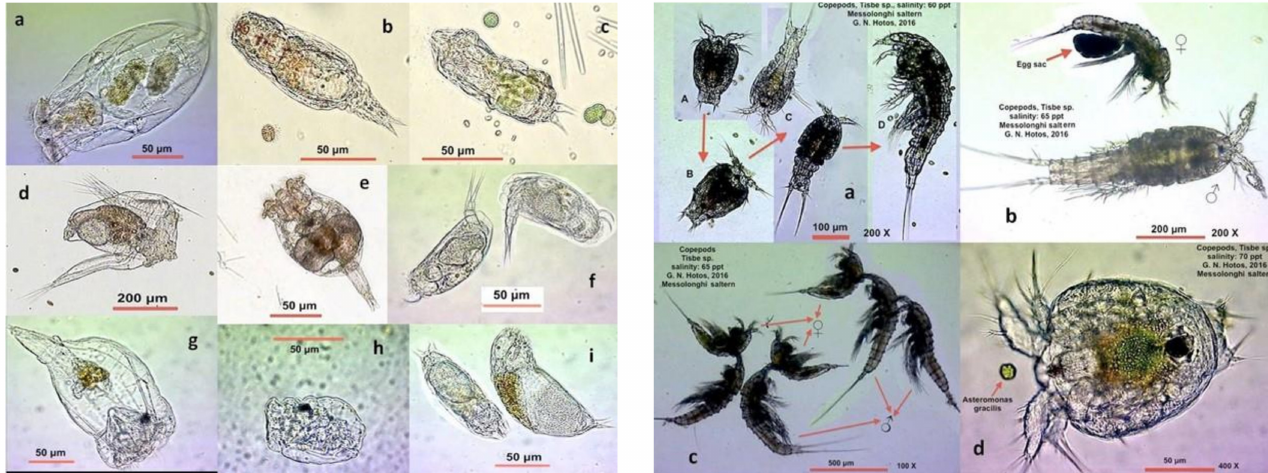
Figure 5. Metazoa from hypersalinity. Left plate: rotifers, ( a ) Testudinella sp.; ( b ) Pleurotrocha sp.; ( c ) Lindia sp.; ( d ) Hexarthra sp.; ( e ) Brachionus plicatilis ; ( f ) Colurella sp.; ( g ) Epiphanes sp.; ( h ) unidentified marine rotifer; ( i ) Encentrum sp. Right plate: copepod Tisbe sp., ( a ) various ontogenic stages, A: early nauplius, B: late nauplius, C: copepodites, D: adult; ( b ) male and female individuals; ( c ) copulation captured photo; ( d ) Tisbe nauplius fed Asteromonas